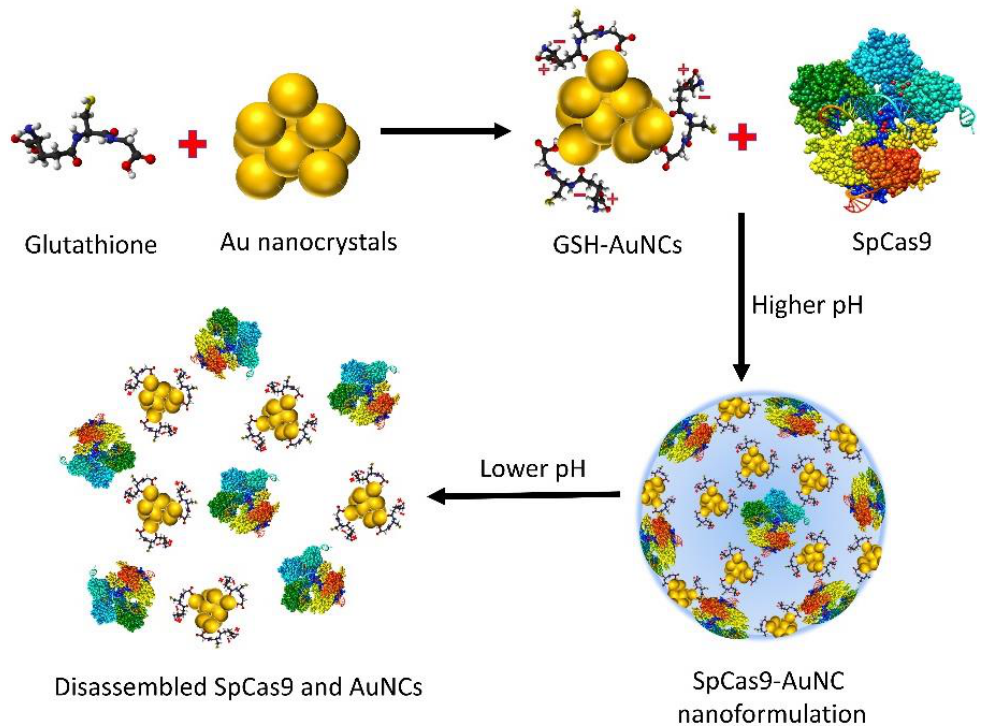
Figure 7. Diagrammatic representation of pH-induced assembly and disassembly of SpCas9- AuNCs. At higher pH, SpCas9 self-assembles with AuNCs through electrostatic interactions, whereas at lower pH, due to weak interactions between SpCas9 and AuNCs, disassembly of this nanoformulation